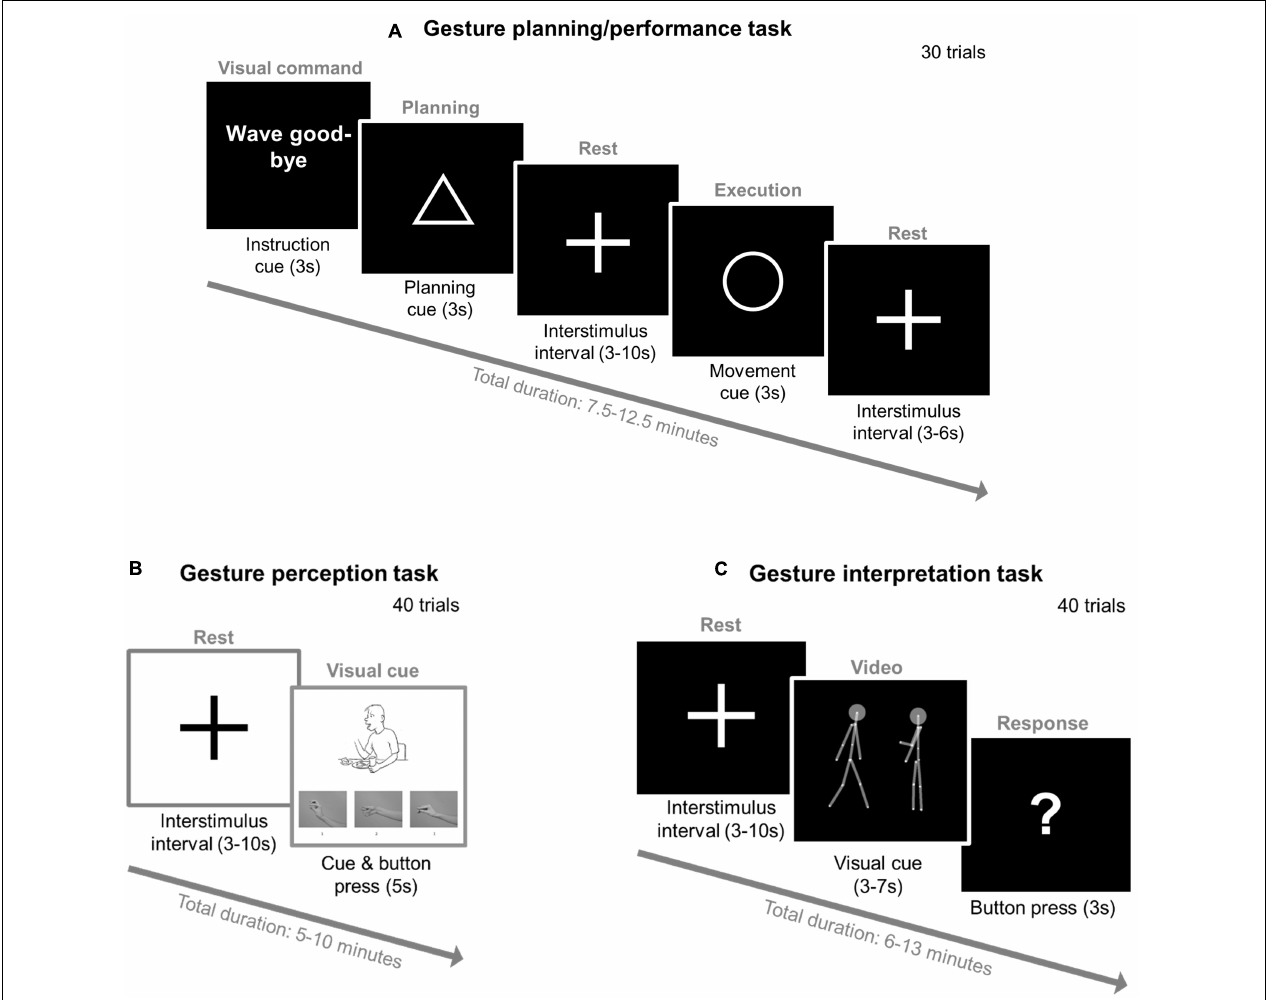
FIGURE 2 | Three fMRI gesture tasks—experimental setup. (A) Gesture planning/performance task with the modified Test of Upper Limb Apraxia (TULIA). Participants will be presented with 20 hand gestures in a random order (e.g., wave good-bye) and 10 control sentences with no gesture performance expected (e.g., “the airline flight is delayed”). Each trial will start with an instruction (3 s), followed by a triangle (planning phase: 3 s), then a 3–10 s interstimulus interval with a fixation cross (3–10 s), a circle (execution phase: 3 s), another 3–6 s interstimulus interval, and then a new gesture of the next trial is presented. (B) Gesture perception task with the modified Postural knowledge task (PKT). Each trial will start with a fixation cross (3–10 s) followed by a picture (max. 5 s) where the hand of the presented figure will be removed. Participants’ task is to choose the correct hand gesture provided below using button presses of a hand pad inside the scanner (1, 2, and 3) and respond while the picture is still displayed. In the example provided the correct gesture is number two. (C) Gesture interpretation task with point-light displays (PLD). Each trial will start with a fixation cross (3–10 s) followed by a PLD video, after which a question mark will be displayed (3 s). The video will include two PLD figures: one on the right side and the other on the left side of the screen. During the video, one PLD will perform a gesture while the other PLD will either follow or imitate these performed gestures. Participants’ task will be to indicate with the button press of a hand pad which of the two PLD figures (left or right) is imitating or following the gestures of the other when the question mark will be displayed. The gray connecting lines and the two gray circles (i.e., PLDs’ heads) are a visual aid and will not be present in the actual